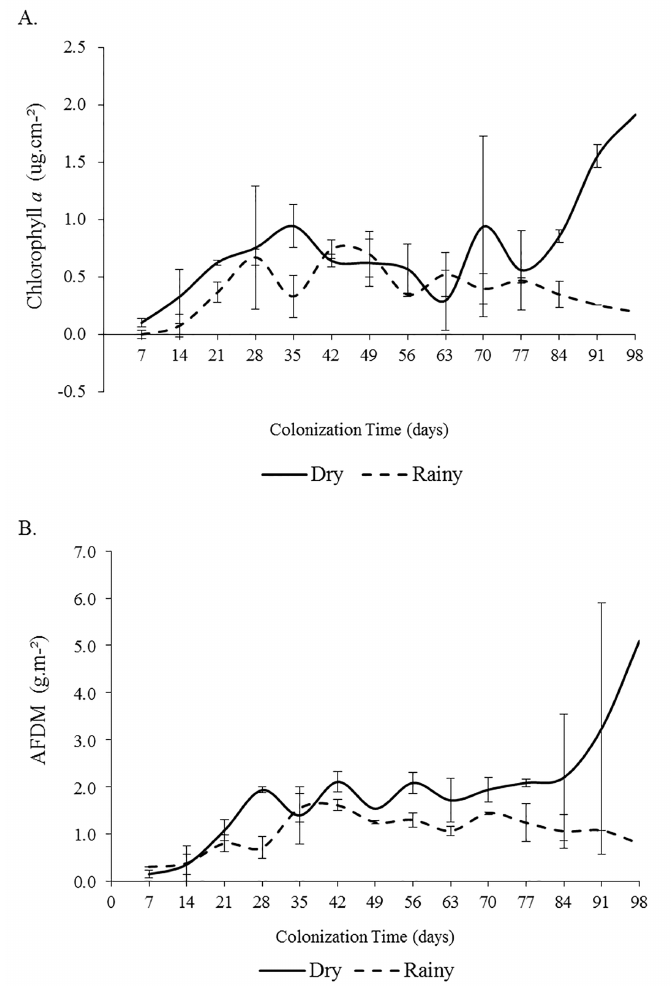
Figure 3. Temporal variation of periphytic biomass (n=2; chlorophyll a (A) and AFDM (B)) over the colonization process in the rainy and dry season in a shallow mesotrophic